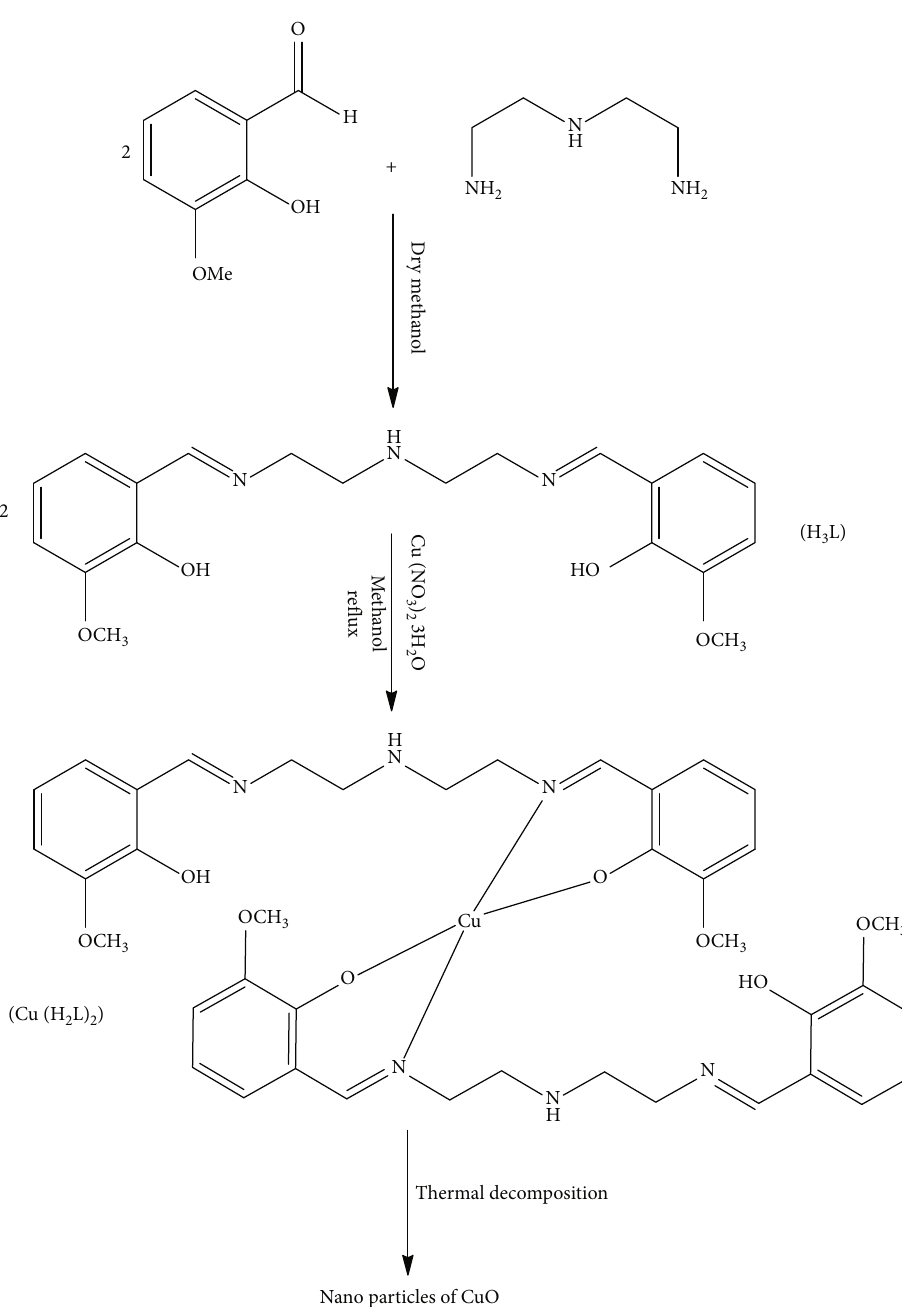
Scheme 1: Preparation of H